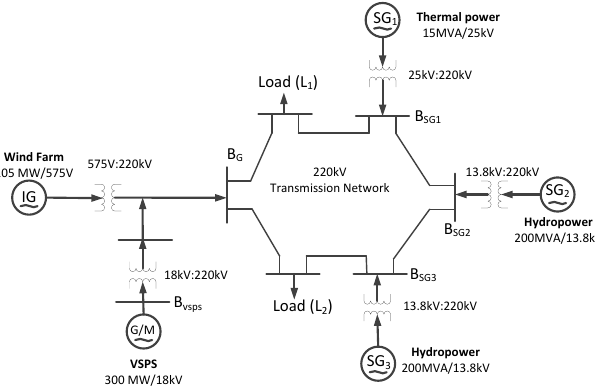
Figure 11. Single-line diagram setup of the VSPS-wind farm-grid integrated system for the case study